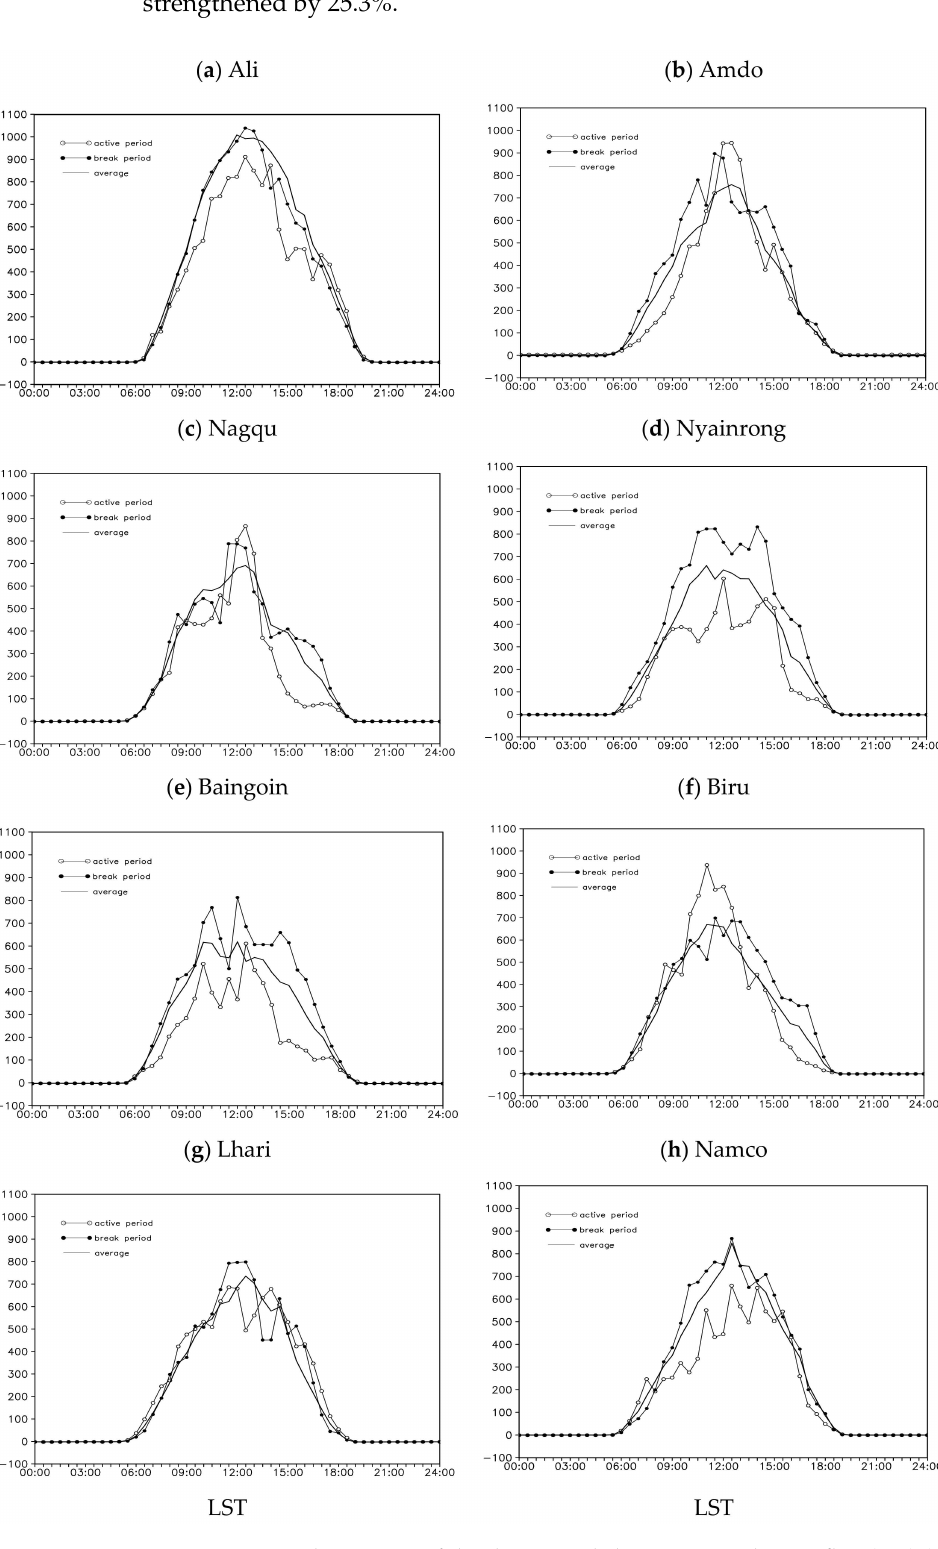
Figure 5. Diurnal variation of the downward short-wave radiation flux (DR) (units: Wm − 2 ) from 8 stations, averaged for the observations, SASM active, and break